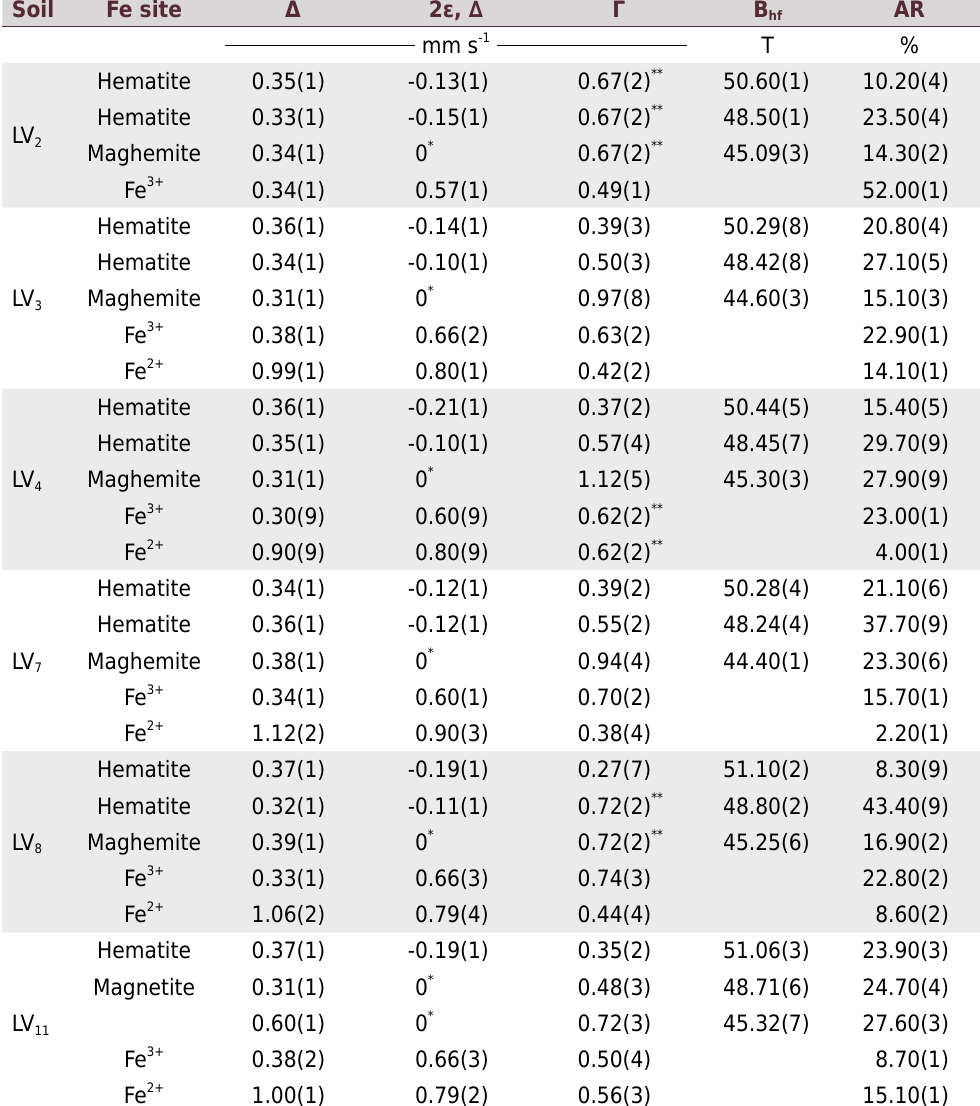
Table 3. 57 Fe hyperfine parameters at room temperature (~298 K) for sand fraction of selected soils LV 2 , LV 3 , LV 4 , LV 7 , LV 8 , and LV